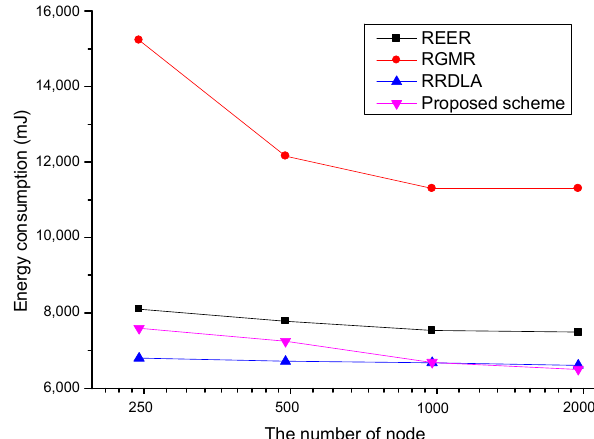
Figure 13. Average energy consumption vs. the number of nodes with 90% of the link